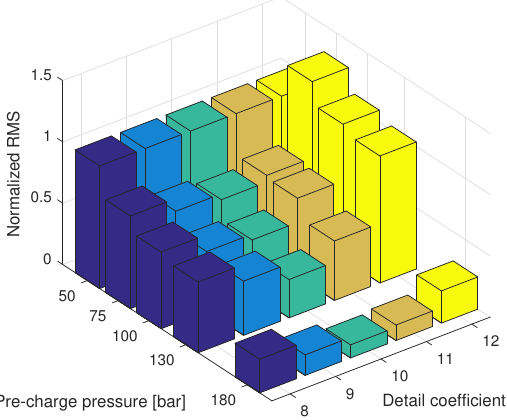
Figure 8. Normalized RMS of the detail coefficient decomposition Levels 8–12 for nominal operating